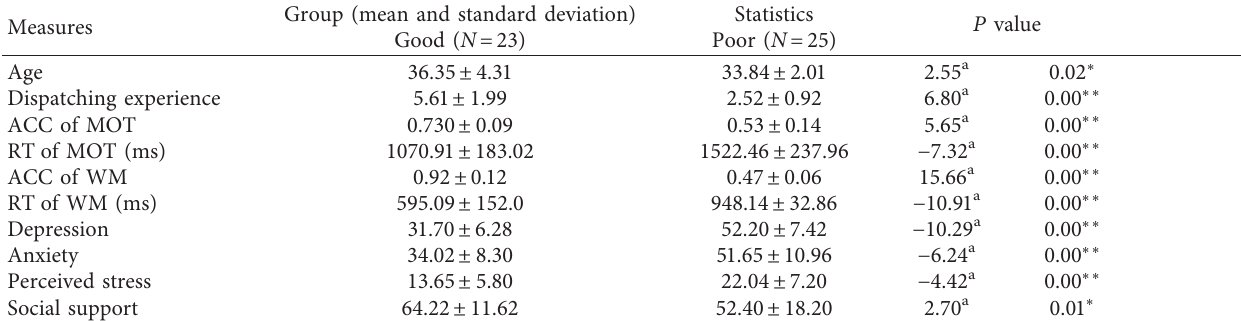
Table 3: Comparison of demographic variables and cognitive variables between two groups ( n � 48).